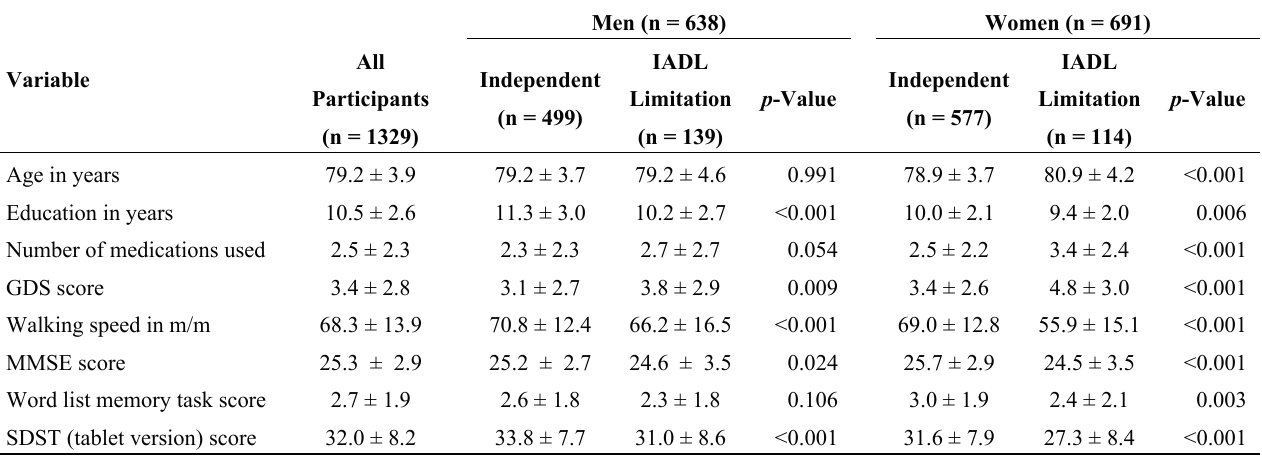
Table 1. Comparison of characteristics between participants with and without self-reported IADL limitation in the baseline survey (n =